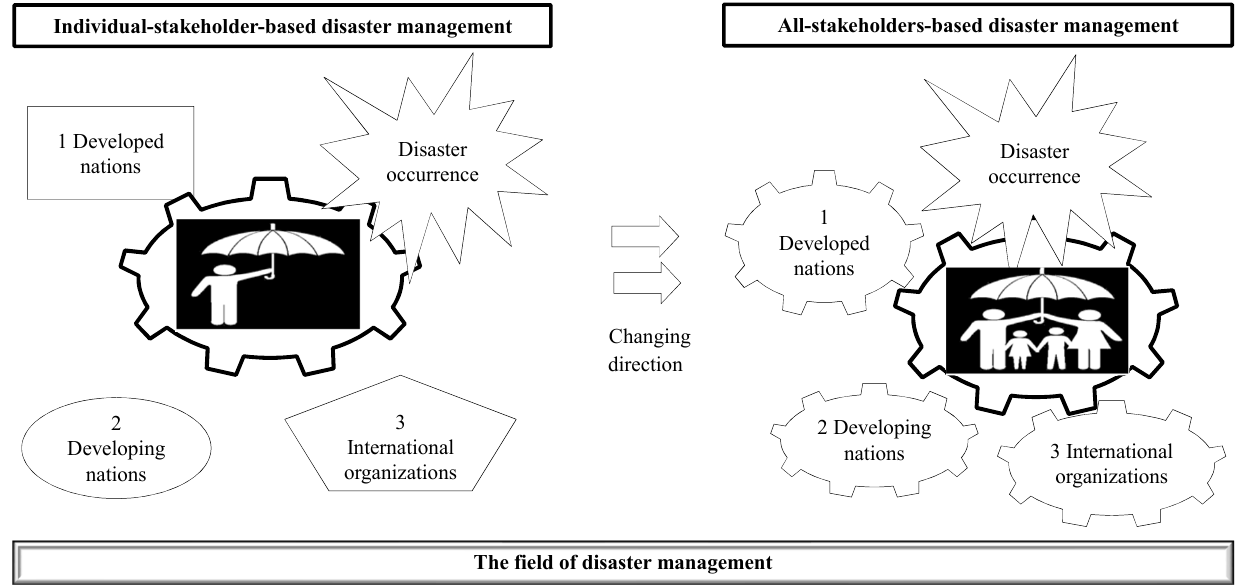
Figure 1. Analytical